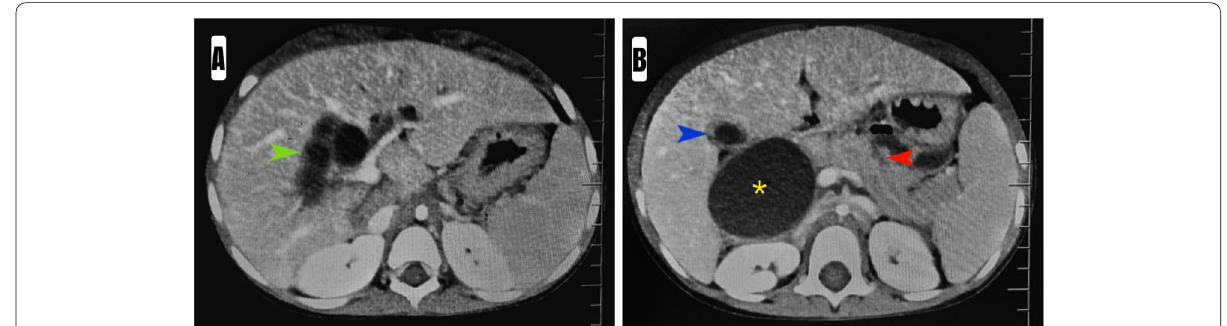
Fig. 1 A and B : Preoperative axial CT scan of the abdomen showing ( A ) multiple intrahepatic biliary radicle dilatations (green arrowhead) and ( B ) a giant cystic dilatation of the common bile duct (yellow asterisk). The main pancreatic duct (red arrowhead) and GB (blue arrowhead) are unremarkable